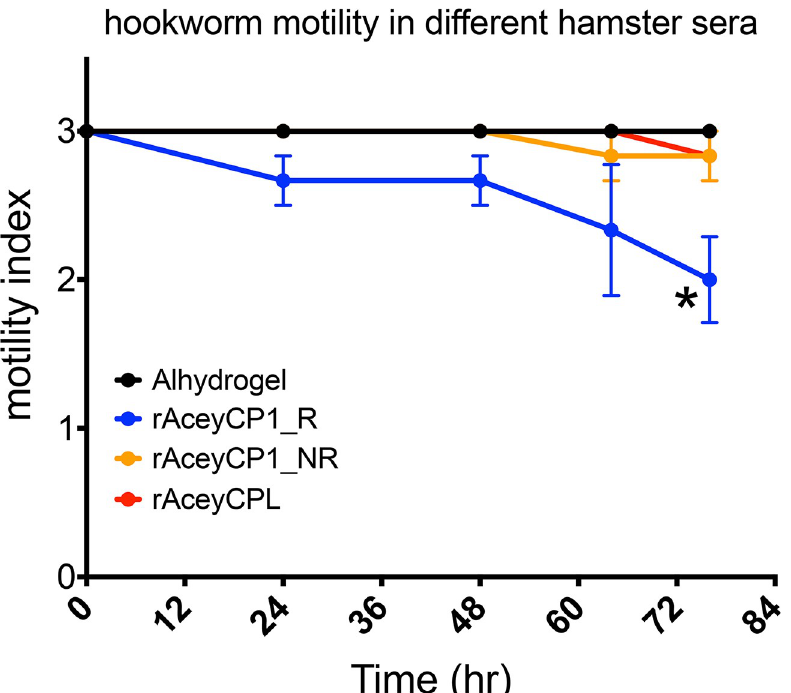
Fig 9. Antisera specifically from rAceyCP1/Alhydrogel IgG responders reduce adult hookworm motility in vitro . Motility of hookworms in different hamster sera over time. Adult A . ceylanicum hookworms were collected from na ï ve (unvaccinated) hamsters and incubated for 76 h in different hamster sera. Motility was scored using a motility index (see Materials and Methods). Shown is the mean motility and standard error. � P = 0.013.